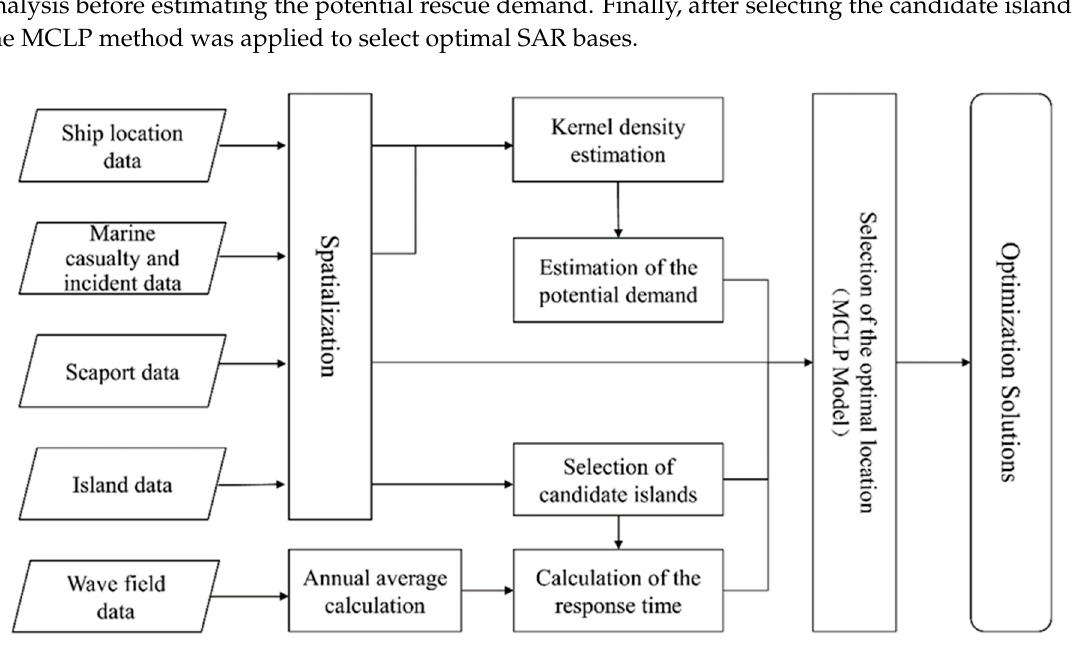
Figure 5. Flowchart diagram of location selection.